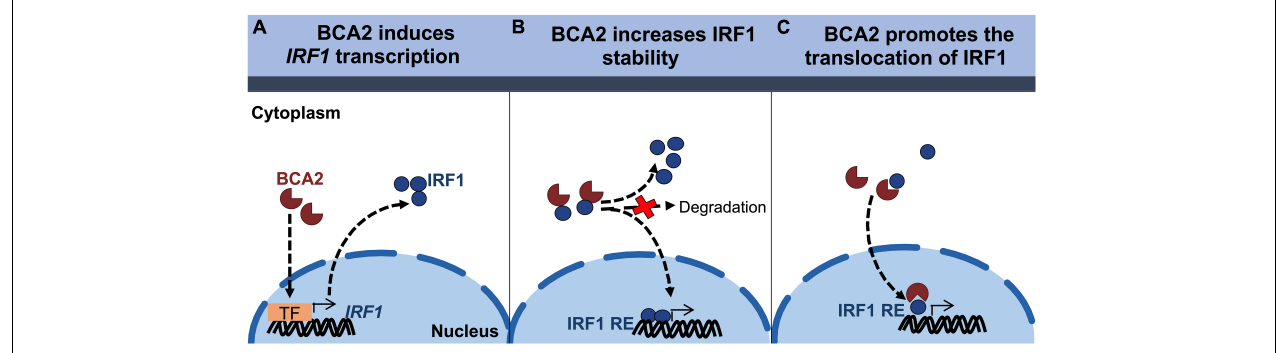
FIGURE 6 | Proposed models for the BCA2-mediated activation of IRF1. (A) BCA2 increases IRF1 activity by upregulating its expression. (B) BCA2 increases IRF1 activity by increasing its stability. (C) BCA2 increases IRF1 activity by facilitating its nuclear transport. TF, transcription factor; RE, responsive element .